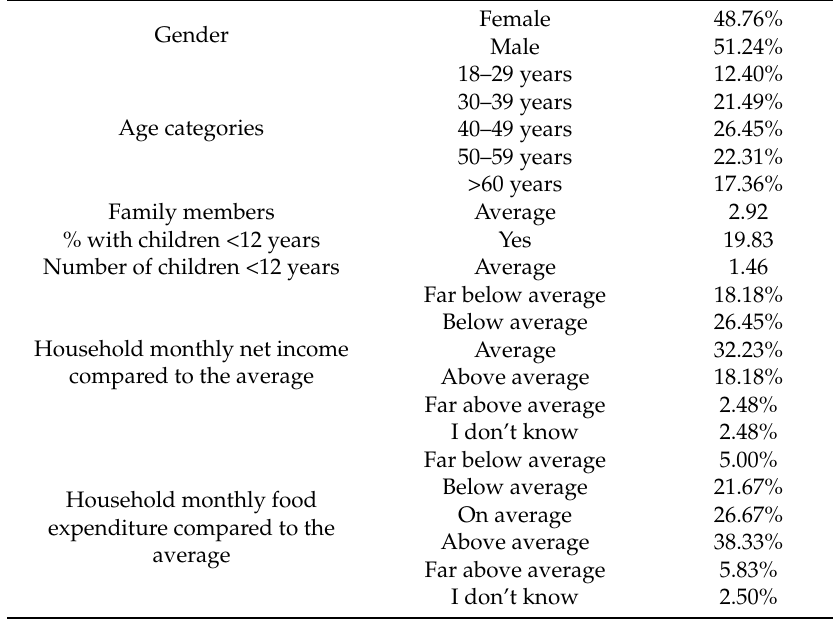
Table 1. Summary of the socio-economic and demographic